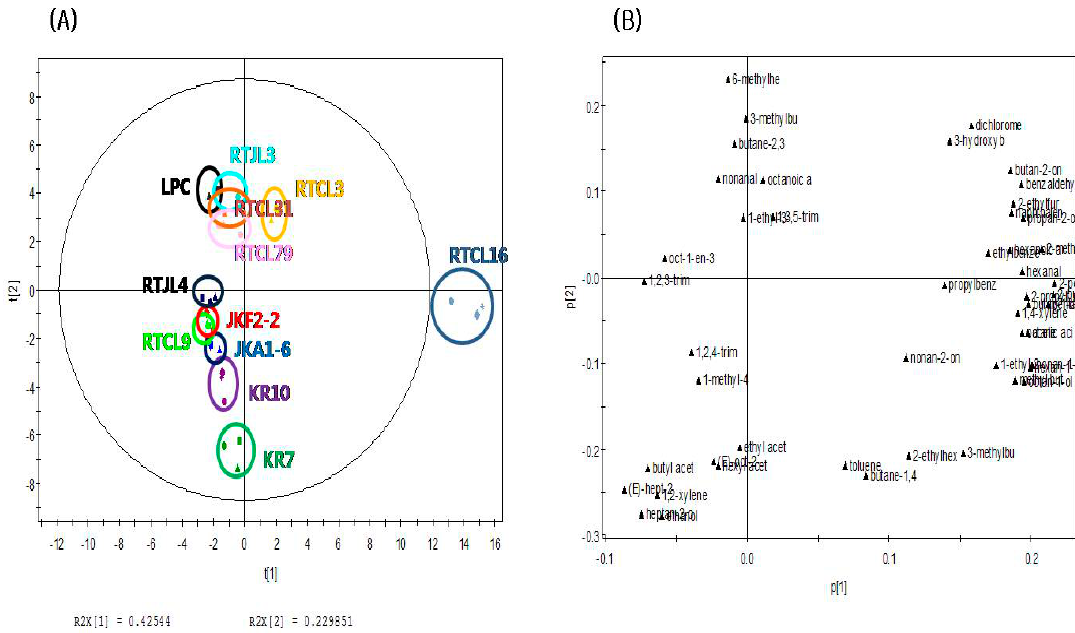
Figure 1. Principal component analysis (PCA) plots of the volatile compounds identified in fermented rice according to strains of LABs: ( A ) score plot, ( B ) loading plot.